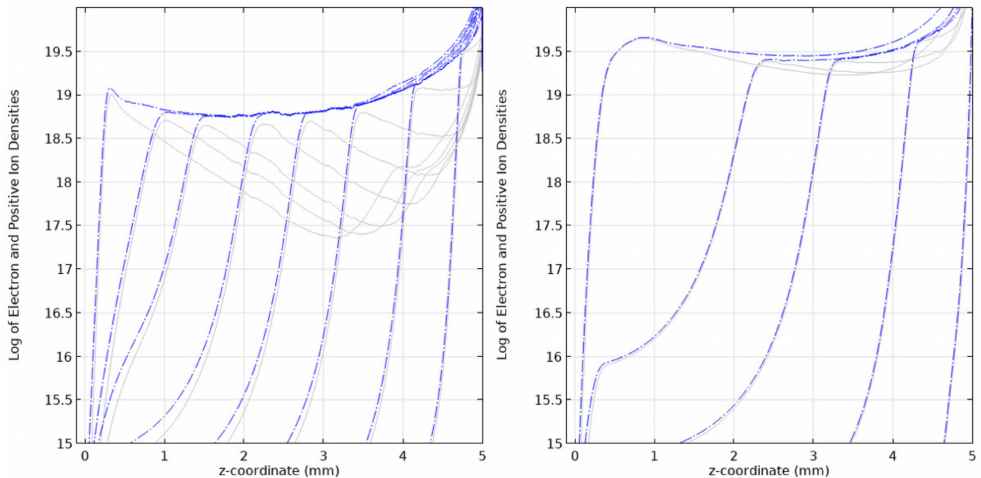
Figure 17. Line diagram of the positive ion density (blue dash-point lines) and electron density (solid gray lines) in SF 6 at 10 kPa when a voltage of 5 kV ( left ) and 10 kV ( right ) is applied. Scaling parameter for density profiles: 20 on logarithmic plot represents a density value of 10 20 m − 3 .